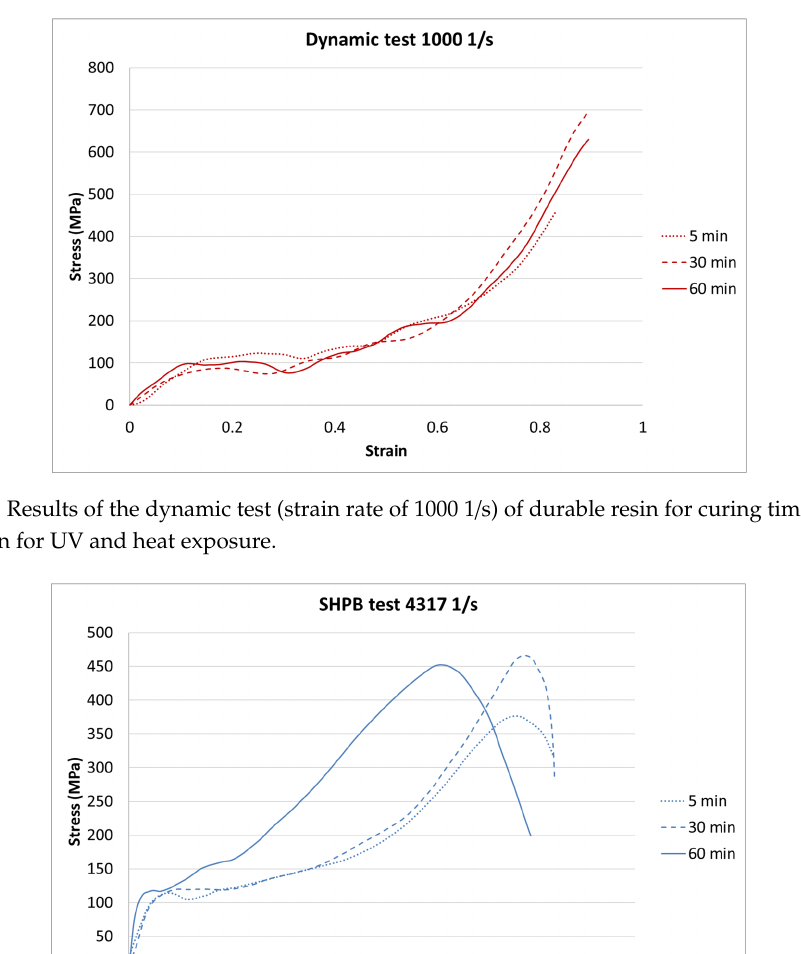
Figure 11. Results of the dynamic test (strain rate of 500 1/s) of durable resin for curing times of 5, 30, and 60 min for UV and heat exposure.